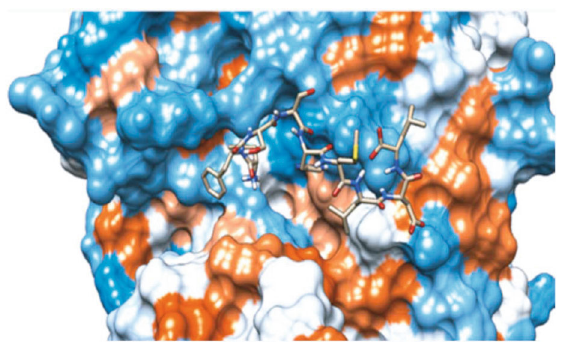
Figure 23: Illustration of the 3D interaction of the best docking poses of LFSSHMLDL in the binding sites of HLA-DRB1 ∗